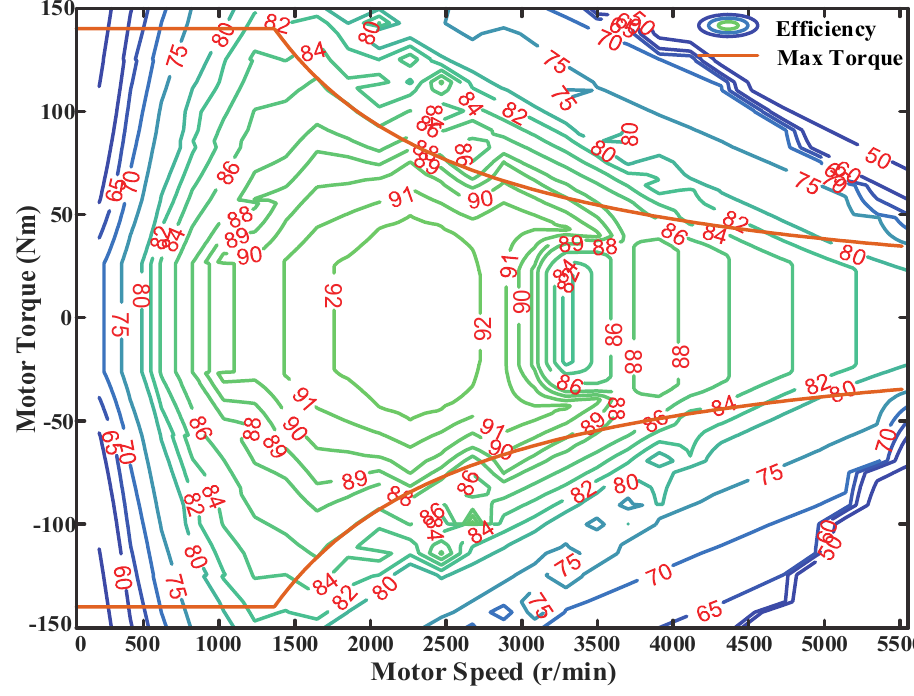
Figure 4. Motor Figure 4. Motor characteristics.